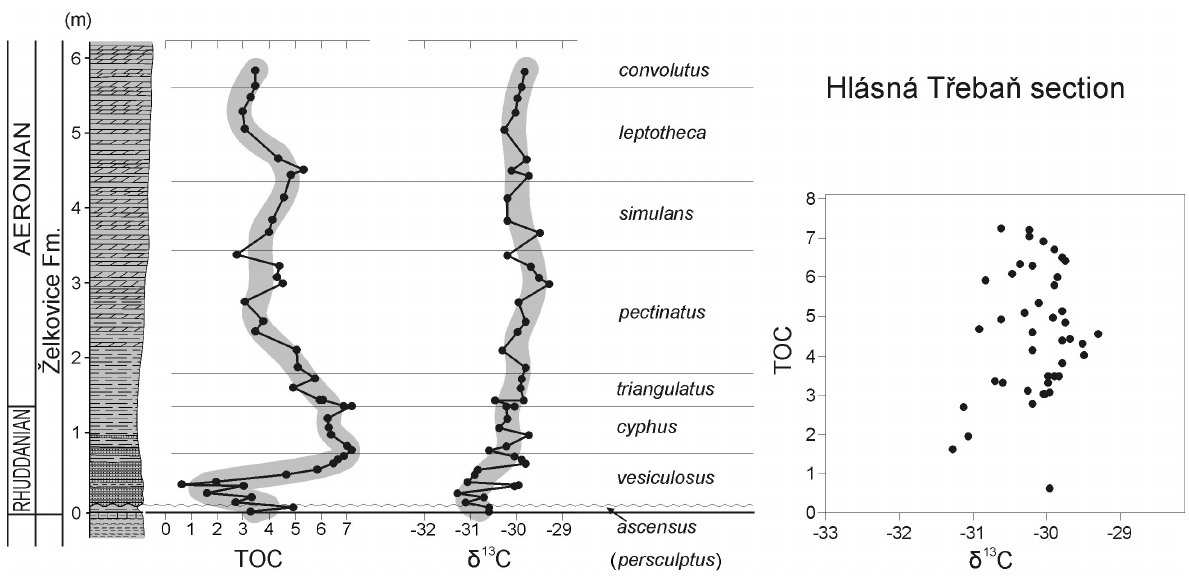
Fig. 4. The δ 13 C org record across the HlasnÆ T ř eban section of the (cid:142)elkovice Formation (Barrandian area; northern peri-Gondwana) and relationship of δ 13 C org ((cid:137) VPDB) and TOC (%) values. The grey line represents locfit regression. See Fig. 2 for